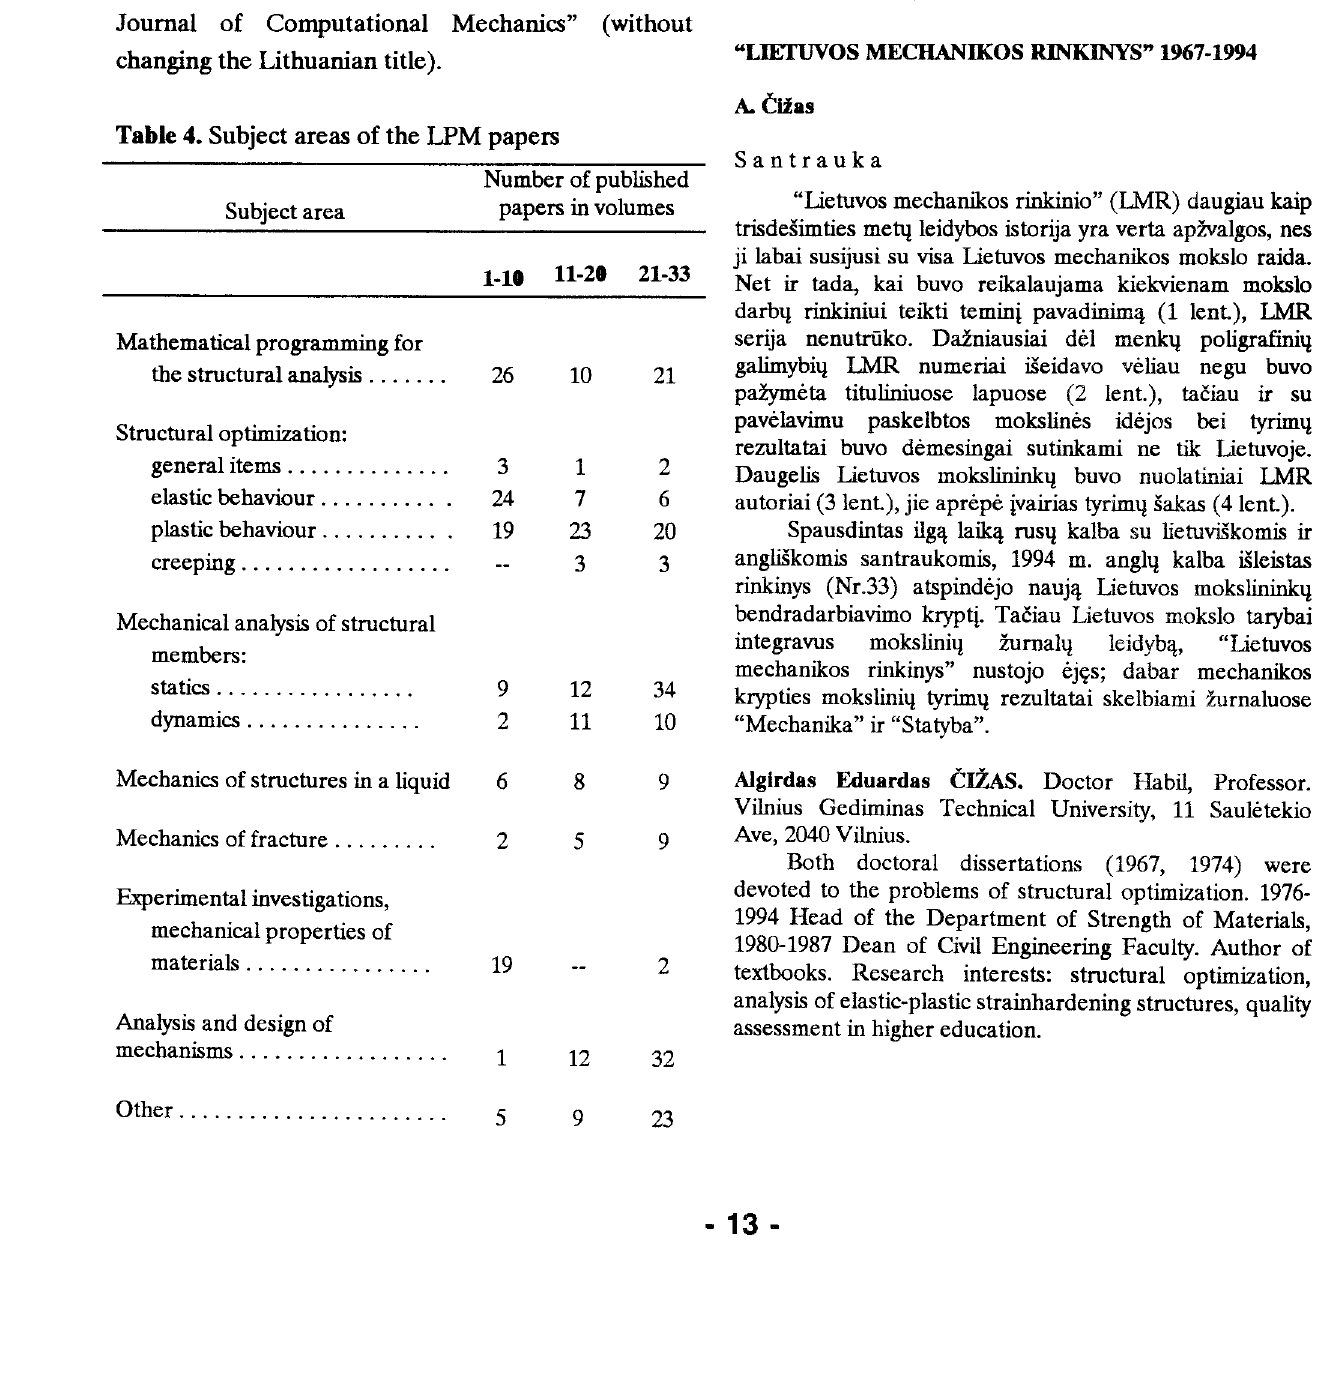
Table 4. Subject areas of the LPM